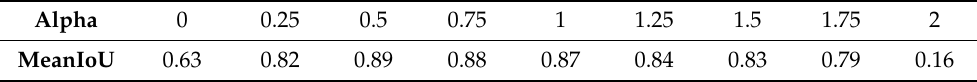
Table 5. IoU of segmentation network DeepLabV3 for different values of alpha in MRI.